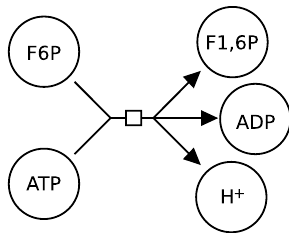
Figure 2.27: Reaction between ATP and fructose-6-phosphate to produce fructose-1,6- biphosphate, ADP and a proton.